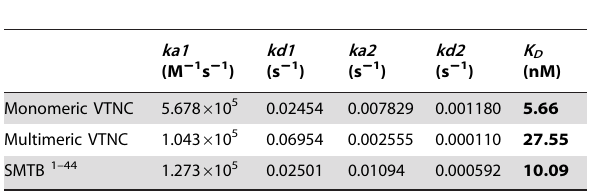
Table 1. Kinetics of Cyr61 interactions with VTNC and SMTB 1–44